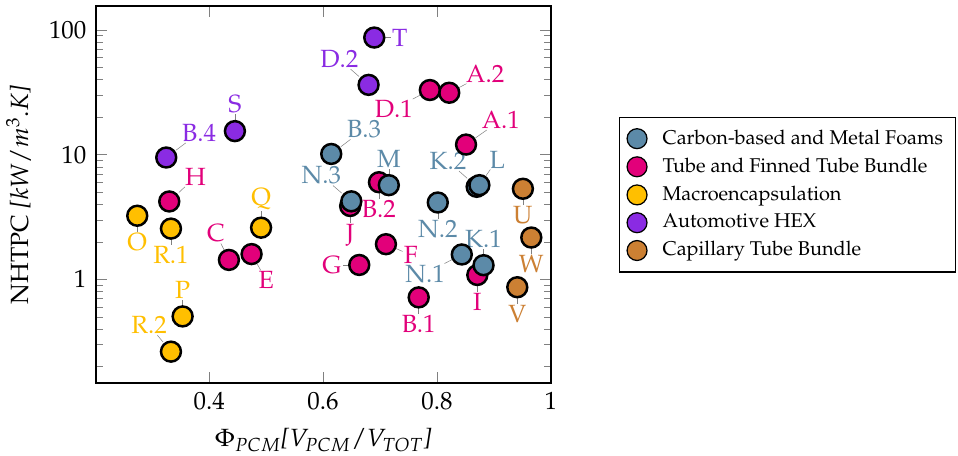
Figure 6. NHTPC vs. Φ PCM for all units in each category in logarithmic